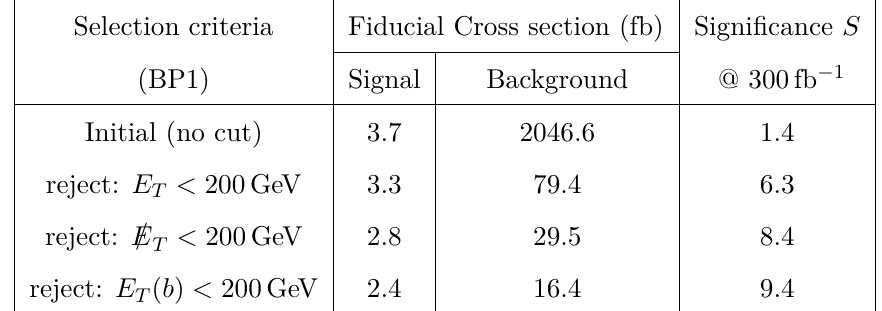
Table 12 . Fiducial cross section of the signal ( pp → d 0 d 0 → bb H 0 ground ( pp → bbνν ) corresponding to BP2 at 14 TeV LHC, with and without the selection criteria considered, and the signal significance at the HL-LHC.